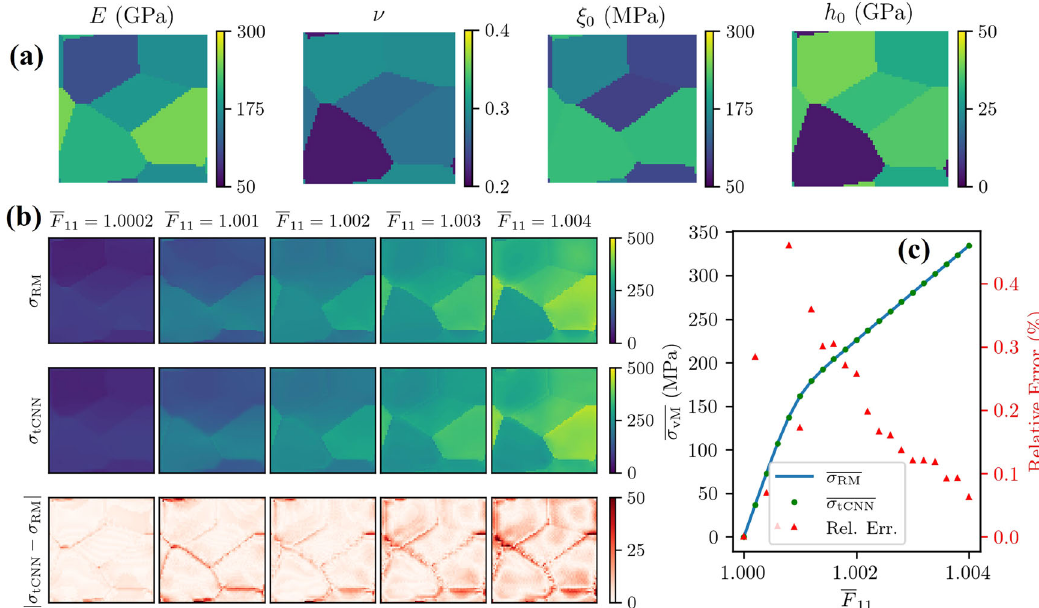
Fig. 1 Five-grain test microstructure subject to uniaxial extension along the horizontal axis. a Young ’ s modulus E , Poisson ’ s ratio ν , initial fl ow resistance ξ 0 , linear isotropic hardening modulus h 0 . b Results for F